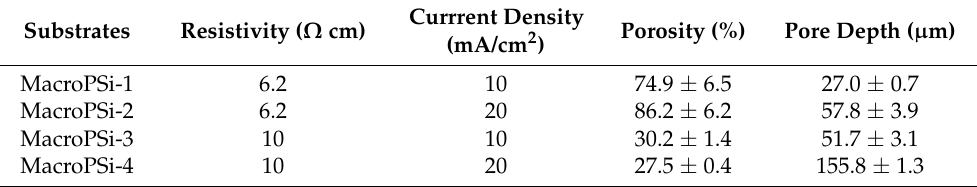
Table 1. Resistivity, anodization current density, resulting porosity and pore depth for macroporous silicon substrates.